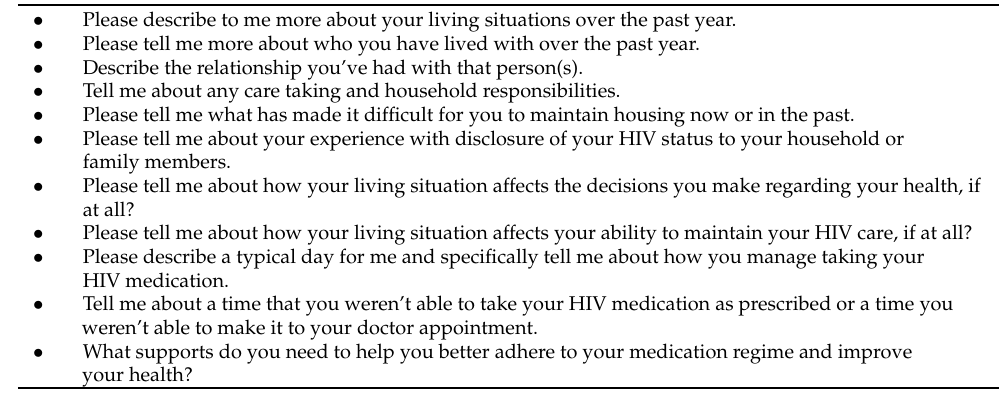
Table 1. Sample Questions Included in the Interview